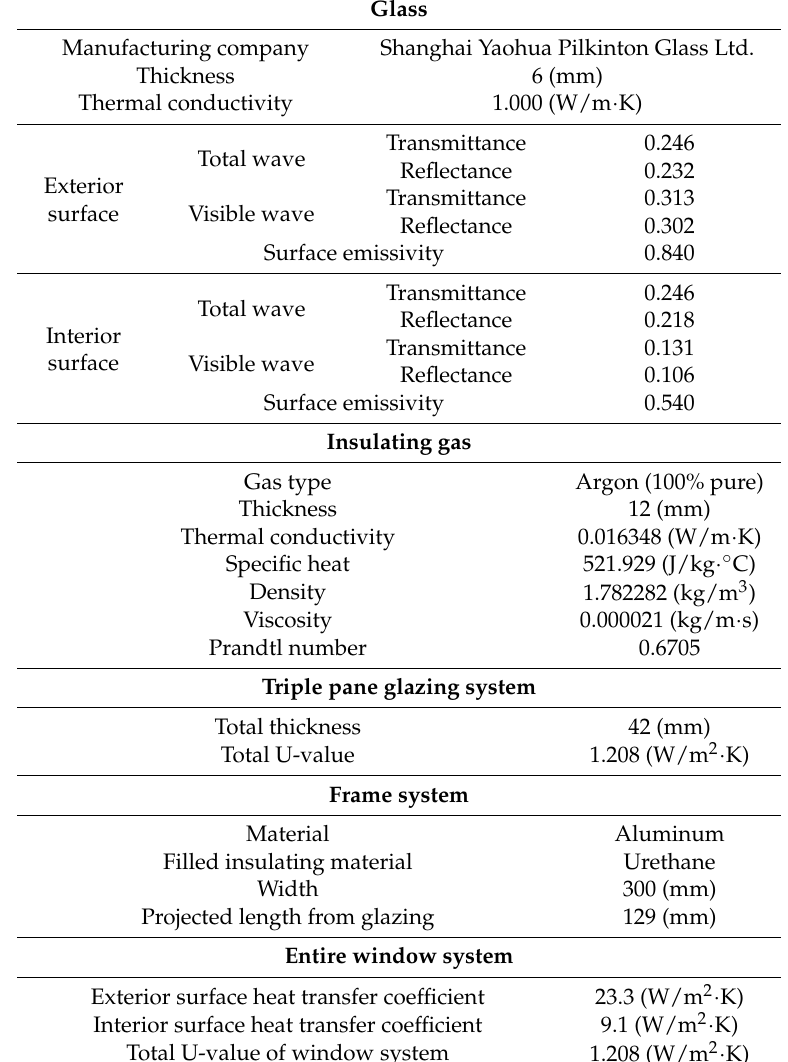
Table 5. Structure and characteristics of the